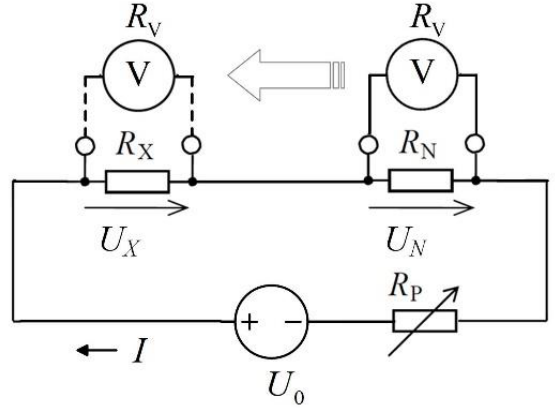
Figure 1. Direct comparison method using a standard resistor and a voltmeter.